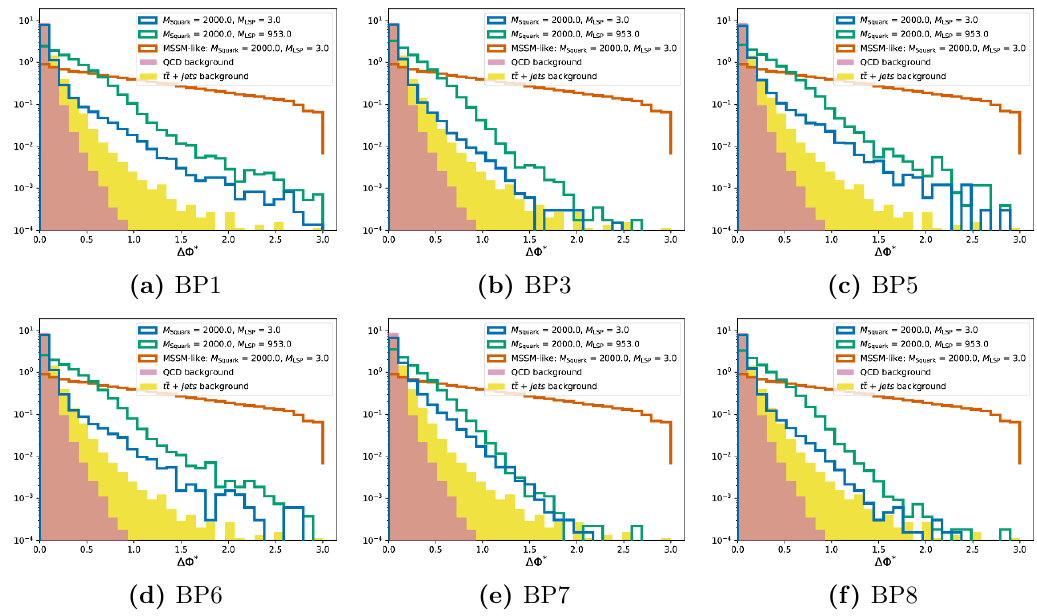
Figure 13. (cid:1) (cid:30) (cid:3) distributions for low and mid-range M LSP near the observed limit in the BP1- type scan, compared with QCD and t (cid:22) t background processes and an MSSM-like scenario with a light LSP.